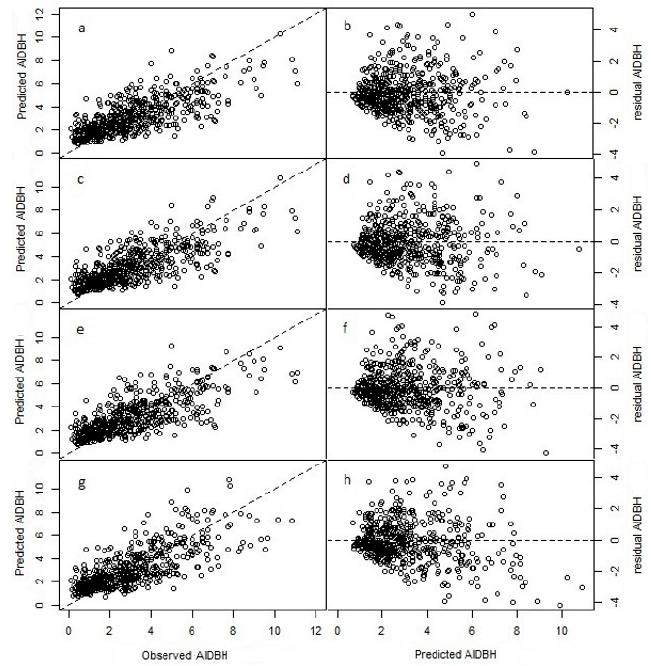
Figure 3. Fit and residuals plots for the natural logarithm of annual increment in diameter at breast height (AIDBH, mm year − 1 ) of selected models using test dataset. Cross-validation (CV, ( a , b )); LASSO ( c , d ); cross-validation with specie-zone factor (CV + SpZone, ( e , f )); and LASSO with specie-zone factor (LASSO + SpZone, ( g , h